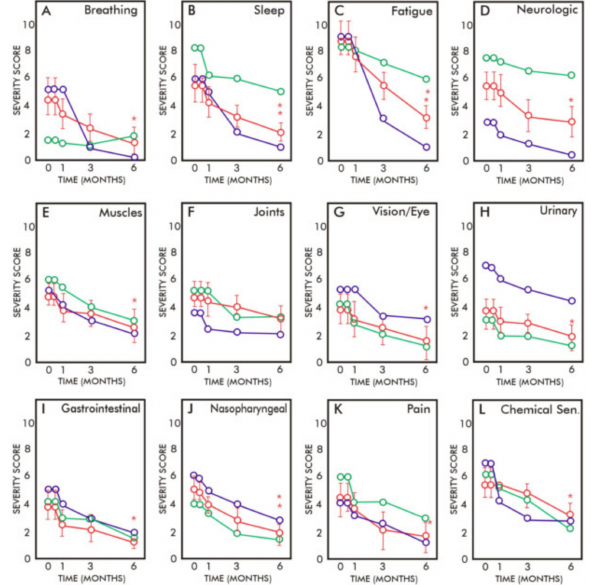
Figure 4. Symptom category scores with time reported by chemically exposed veterans who took the oral MLR supplement NTFactor Lipids ® (6 g per day) for 6 months. The mean symptom category severity scores of all 16 trial participants (red symbols with standard error of the mean) are compared to two individual subjects (green and blue symbols) before the trial and at one week, one month, 3 months and 6 months. Each symptom category represents the mean of 3–6 individual symptoms. ( A ) Breathing difficulties, ( B ) Sleep disturbances, ( C ) Fatigue, ( D ) Neurologic symptoms, ( E ) Muscle symptoms, ( F ) Joint symptoms, ( G ) Vision/eye disturbances, ( H ) Urinary symptoms, ( I ) Gastrointestinal symptoms, ( J ) Nasopharyngeal symptoms, ( K ) Pain, and ( L ) Chemical sensitivities. *, p < 0.01; **, p < 0.001. Modified from Nicolson and Breeding